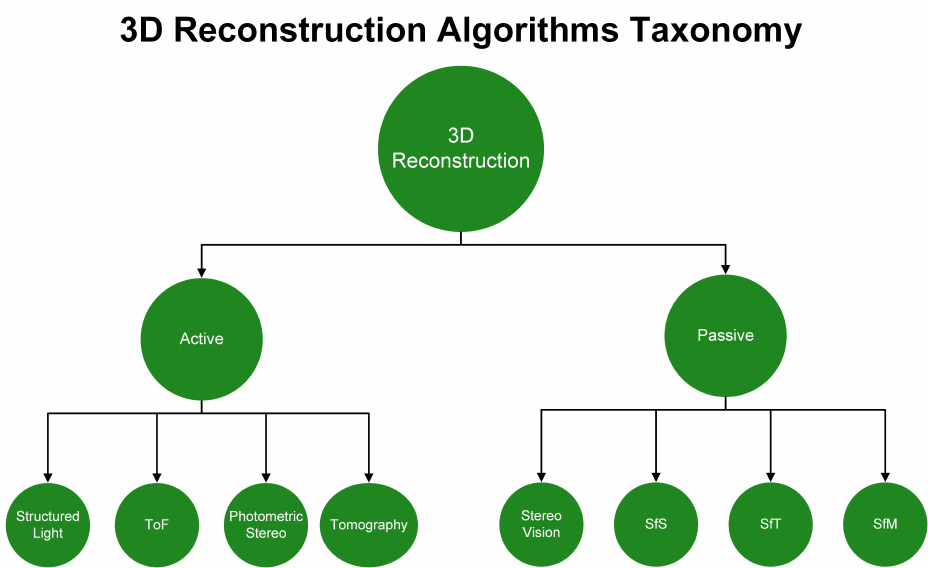
Figure 1. Three-Dimensional (3D)